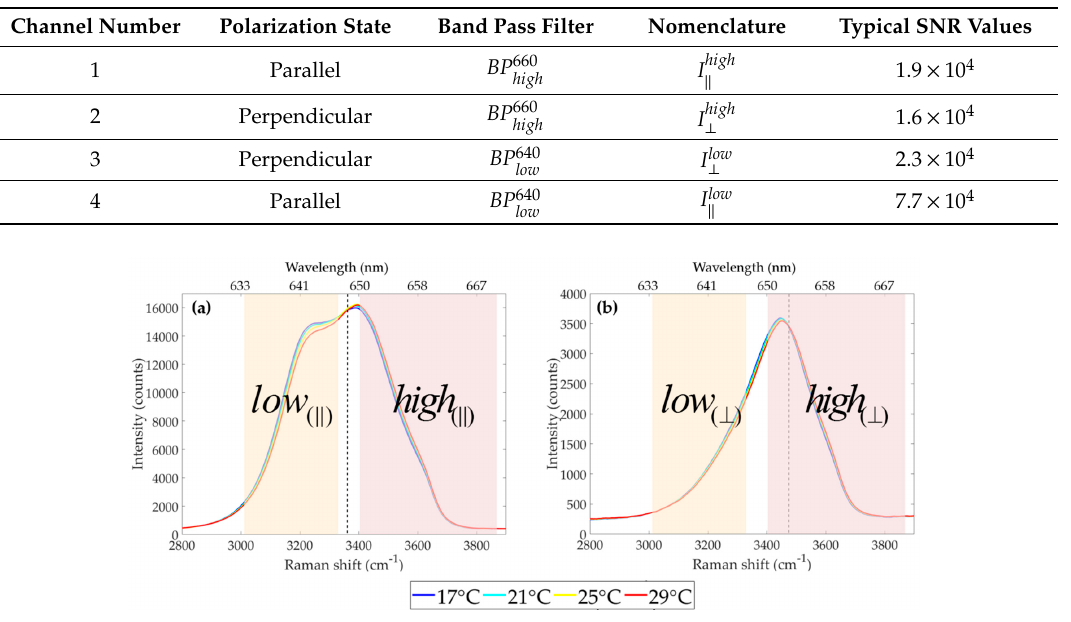
Figure 3. Band pass filter transmissions superimposed on (a) parallel and (b) perpendicularly-polarized Raman spectra. Low and high channels are indicated by shaded areas.